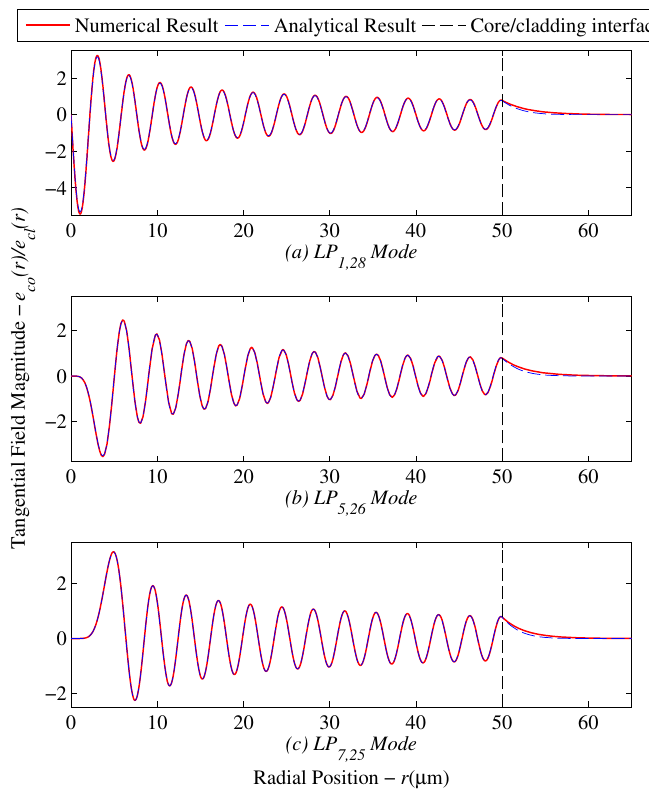
Figure 6. Radial field comparison for step index and diffusion modeled fibers for selected modes ( a ) LP 1,28 , ( b ) LP 5,26 and ( c ) LP 7,25 .